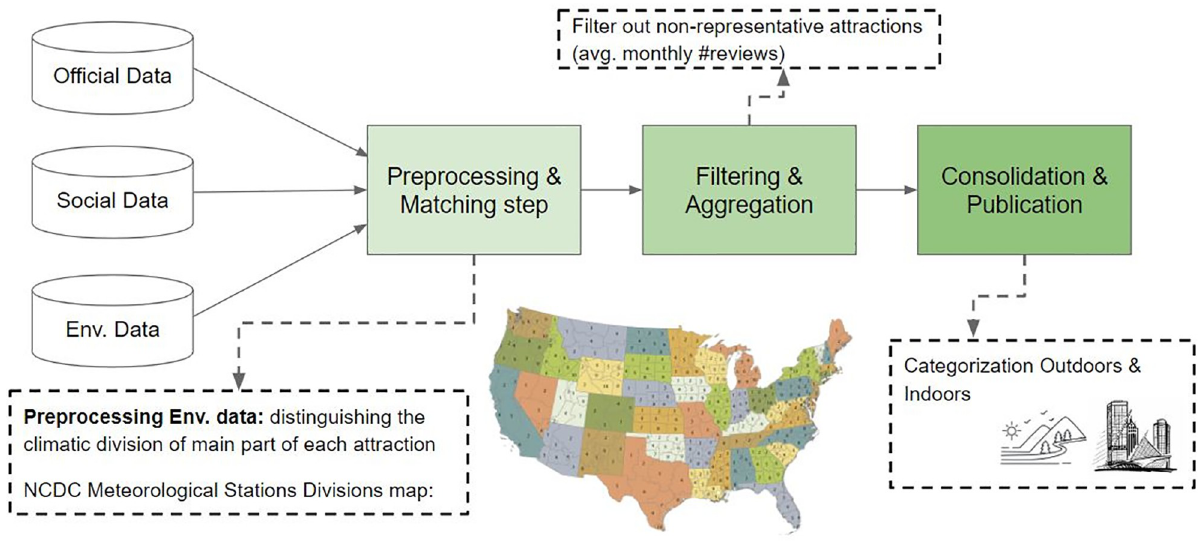
Fig 1. Data collection phases.